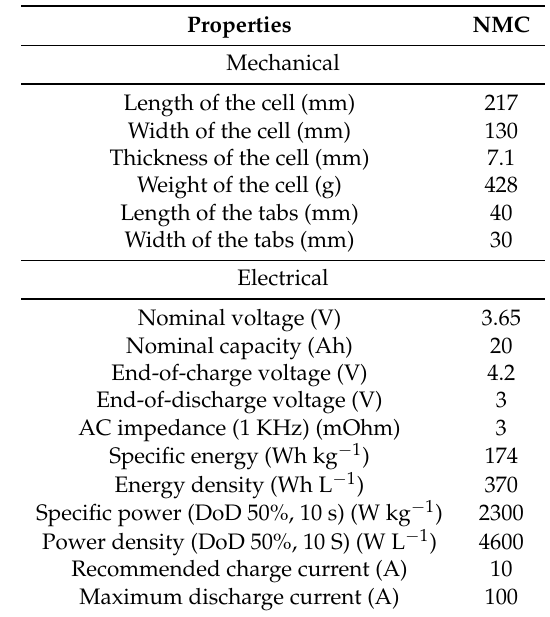
Figure 1. Picture of the nickel manganese cobalt oxide (NMC) cell, lying on a sheet of A4 paper. Table 1. Characteristic properties of the NMC cell. DoD: depth of